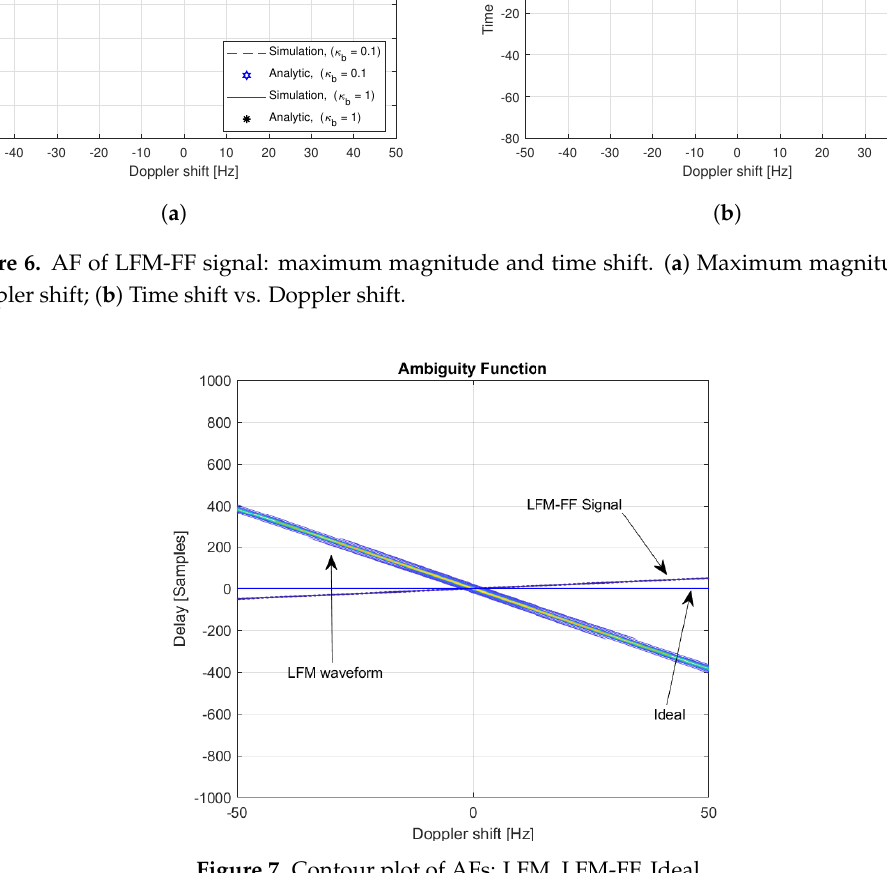
Figure 7. Contour plot of AFs: LFM, LFM-FF,